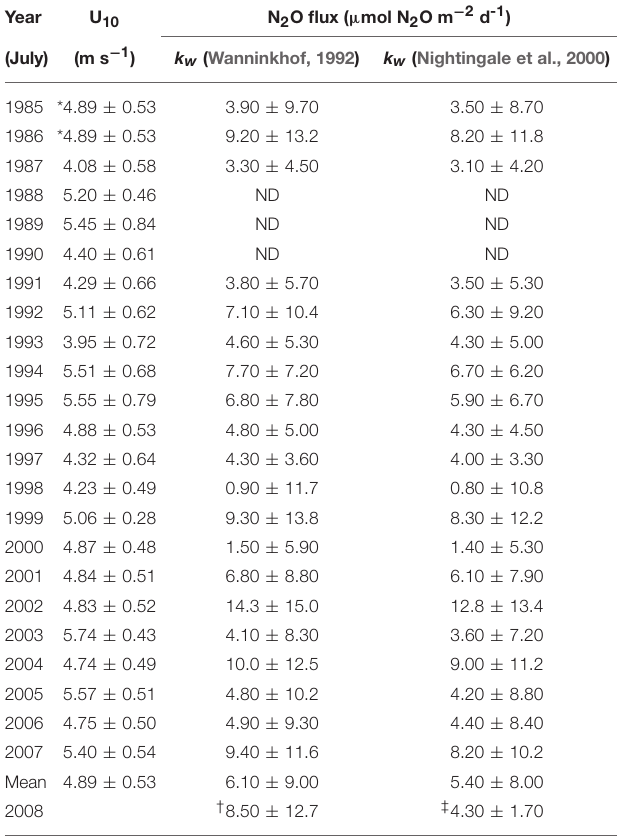
TABLE 1 | Summary of July mean wind speeds (U 10 ; m s − 1 ) and estimated mean N 2 O fluxes for July in the